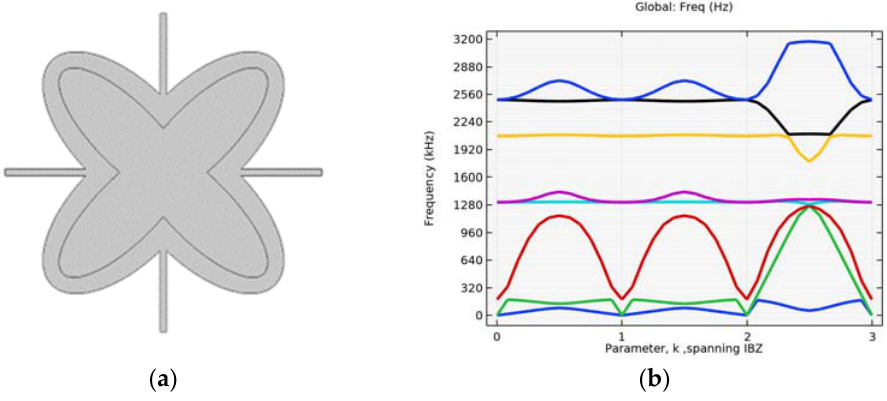
Figure 9. Response for inner ellipse 170 × 60 and rod thickness 6 mm (a) microstructure, (b) responce for first eigenfrequenciew. One band gap between 5th and 6th eigenfrequency (1440–1780 Hz).